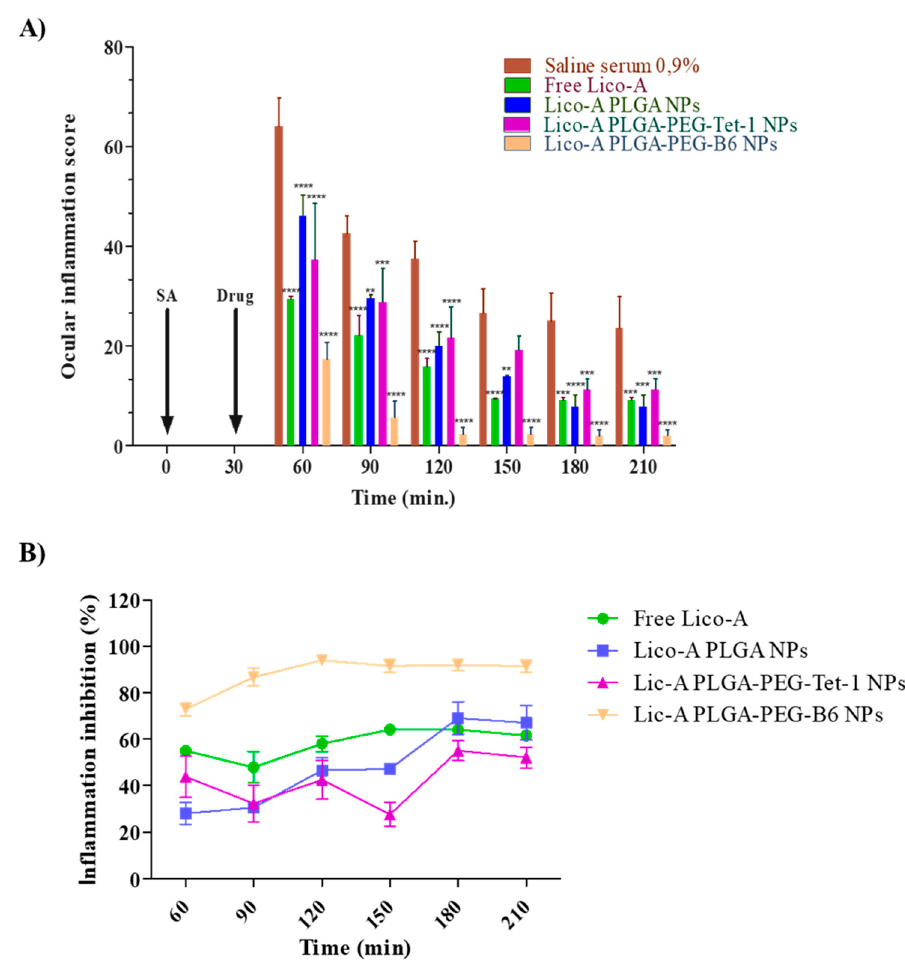
Figure 7. Ocular anti-inflammatory results. ( A ) Ocular inflammation score. ( B ) Inhibition of inflam- mation (%). Significant differences compared to the saline serum group: ** p < 0.01; *** p < 0.005; **** p < 0.0001.